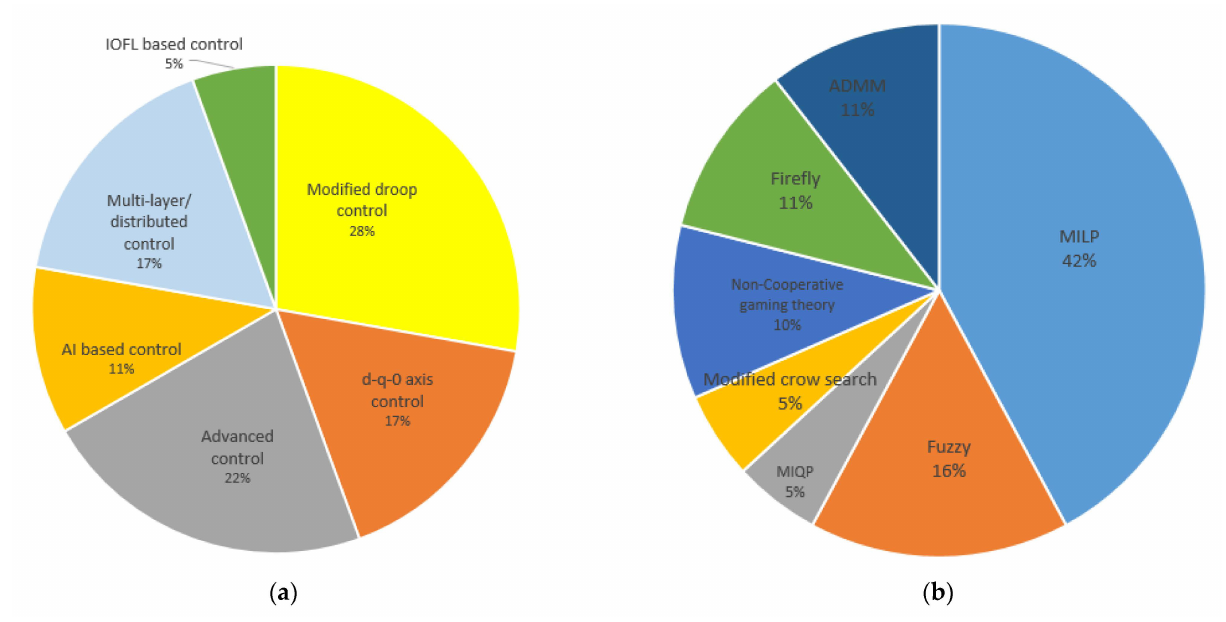
Figure 11. Distribution of multiple techniques used for power management ( a ). Interlinking converter control techniques ( b ). Next-day forecasting-based supervisory control techniques.